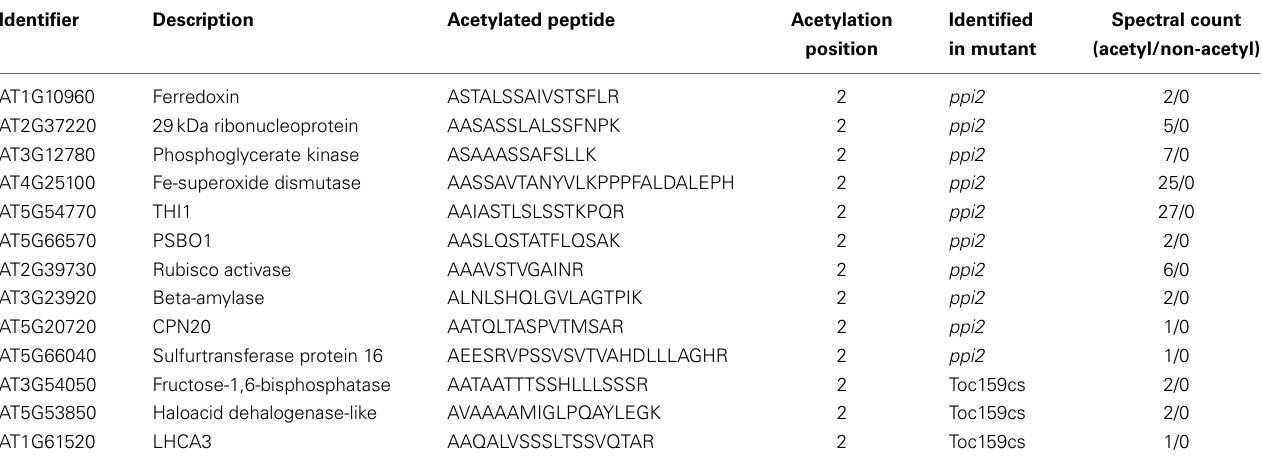
Table 1 | N-terminally acetylated peptides in chloroplast precursor